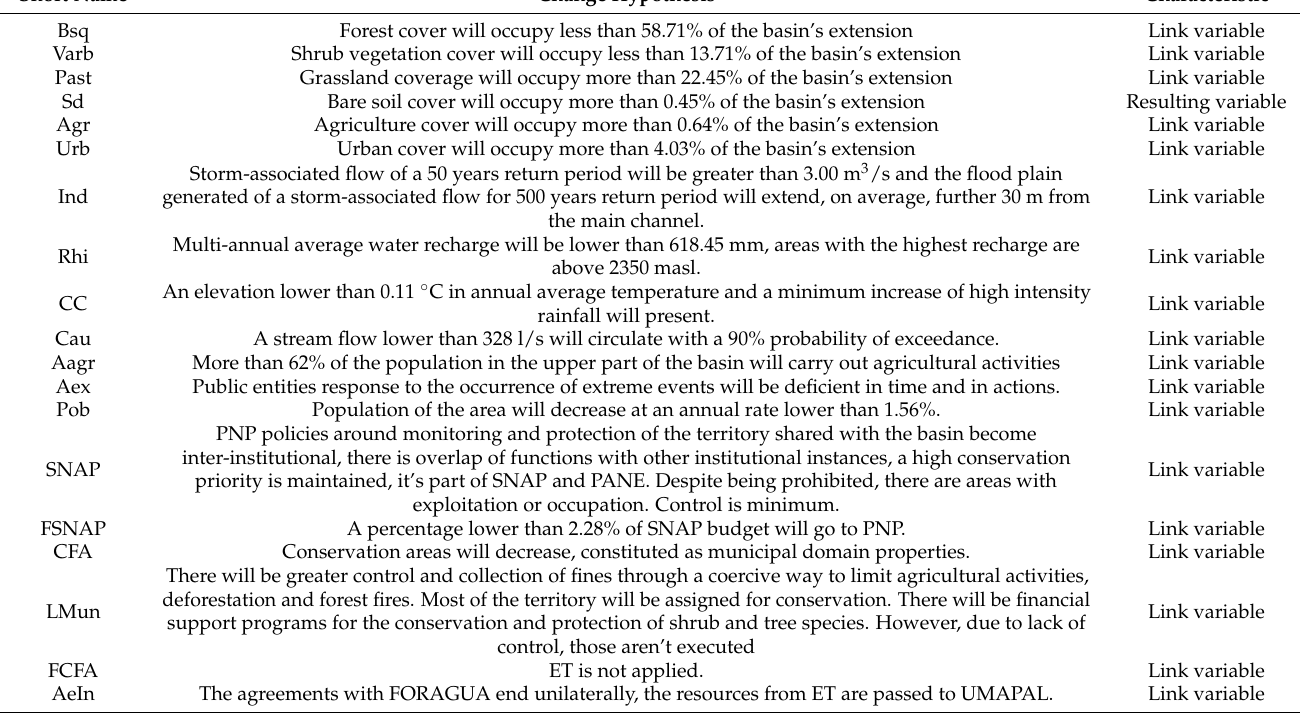
Table 5. Negative future change scenario, hypothesis by variable, and its